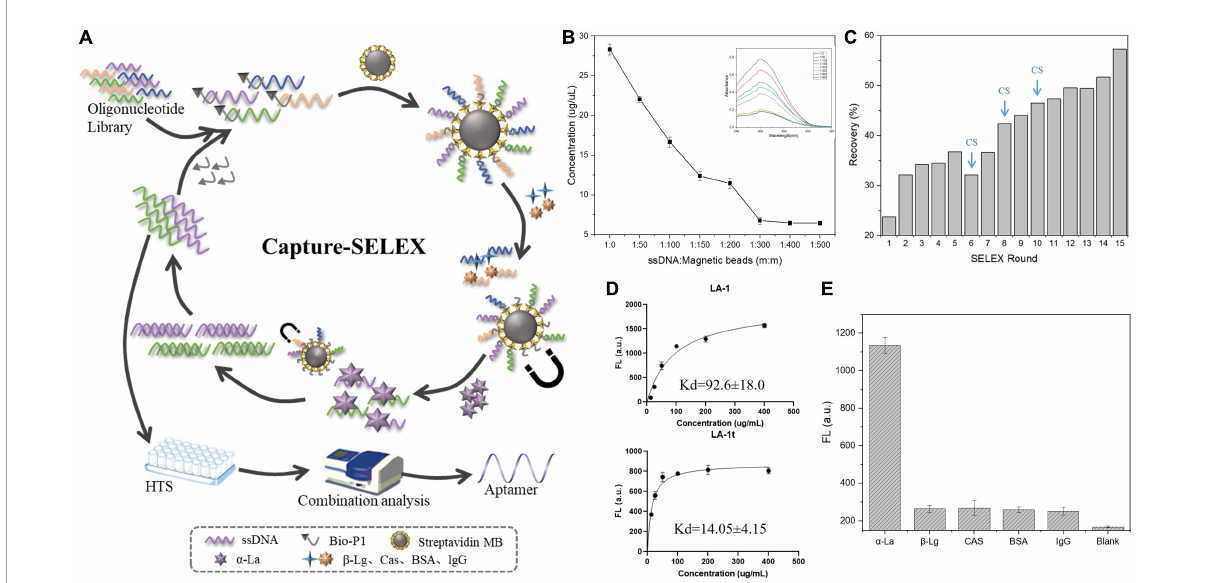
FIGURE1 (A) Principle of selecting α -lactalbumin ( α -La) aptamers using capture-SELEX; (B) Optimization of the mass ratio of ssDNA to streptavidin magnetic beads; (C) Relative enrichment rate during SELEX for monitoring; (D) The binding saturation curves of aptamer LA-1 and LA-1t; (E) The specificity of